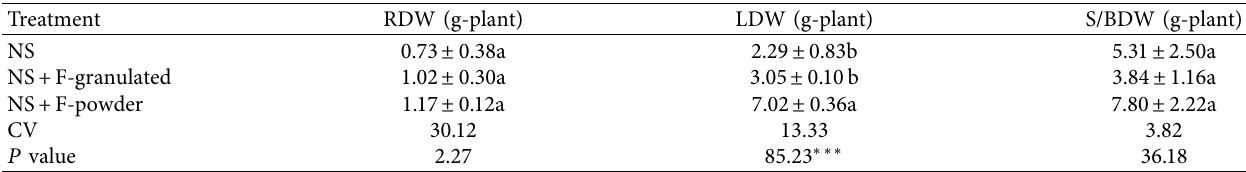
Figure 1: Characteristics of the cherry tomato “Atomic Grape” by the effect of the NS, F-granulated, and F-powder. Table 2: Effect of NS and organomineral fertilizer on dry weight in cherry